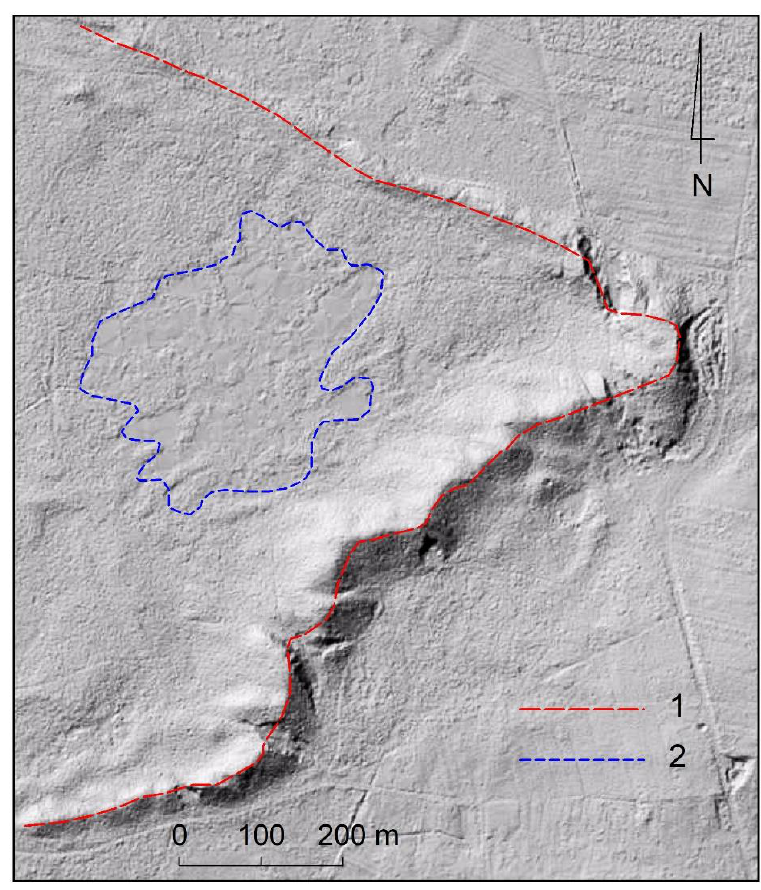
Figure 3. Geomorphological conditions of the location of the post-exploitation peat reservoir 3: 1: dune ridgeline, 2: reservoir bank (source: own study based on an image LIDAR obtained from geoportal.gov.pl (accessed on 27 December 2021)).